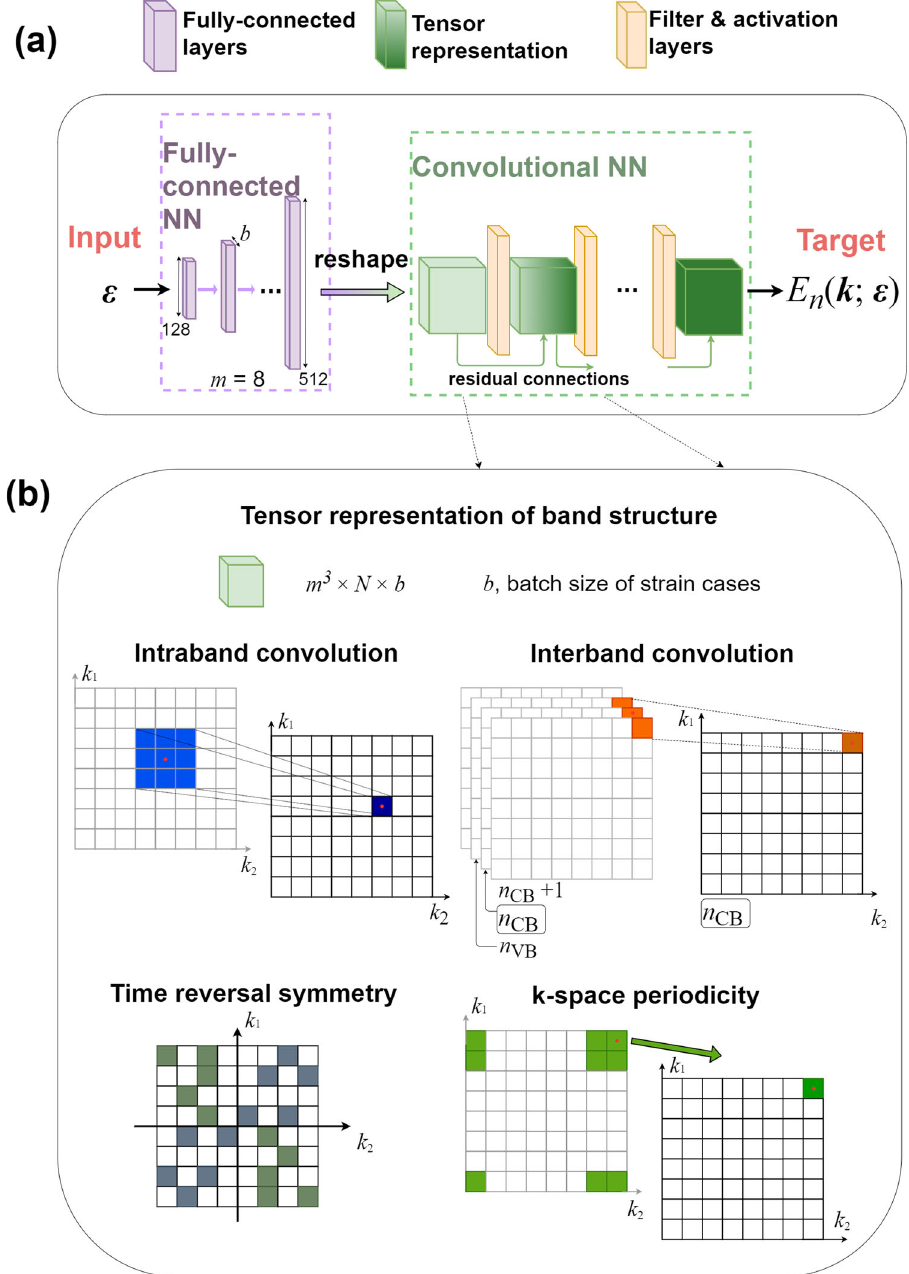
Fig. 2 ML model description. a CNN architecture for band structure prediction. The strain components are passed through fully connected layers, with the last layer reshaped into a rank-5 tensor. After a few convolutional layers with residual connections that improve convergence, the network produces the band structure as the output, which is fi tted against the targeted DFT-computed band structure. A mesh comprising 8 × 8 × 8 k - points are used. b Tensor representation and physical insights incorporated into the CNN model: time-reversal symmetry, k - space periodicity, and inter-band and intra-band